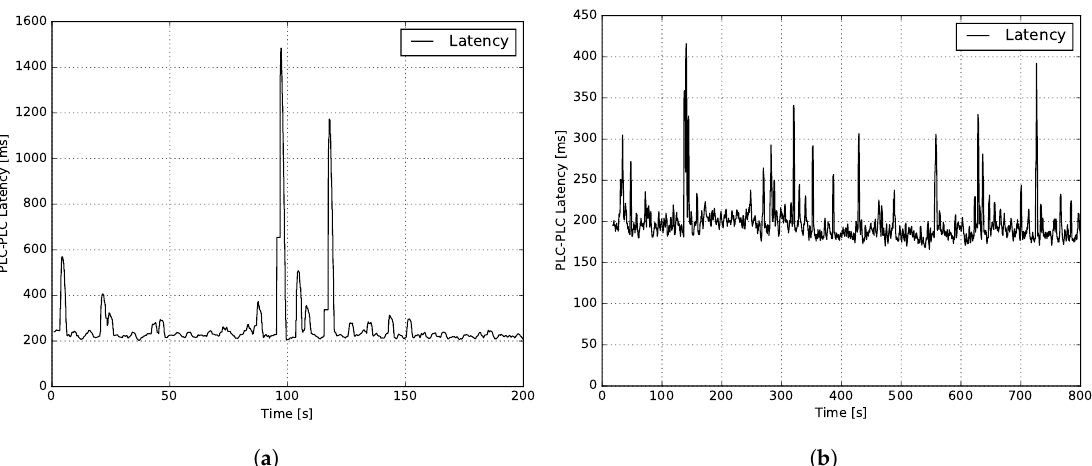
Figure 15. Latency time between onboard and onshore PLCs: ( a ) canal in Leuven, and ( b ) lake in